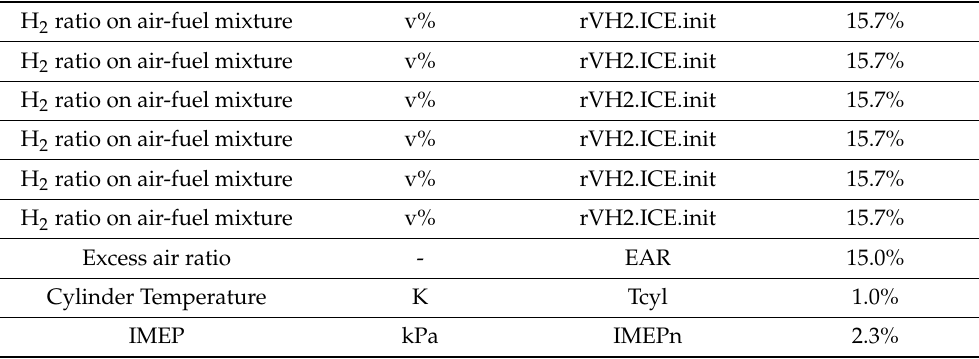
Table 7. Errors in